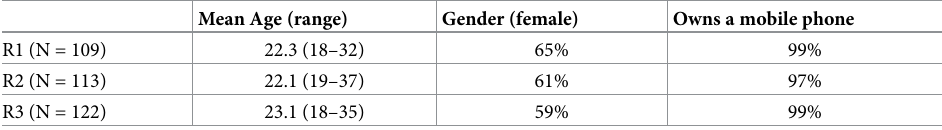
Table 2. Sample characteristics of the studies of hazard identification (R1), risk characterization (R2), risk protec- tion by risk management